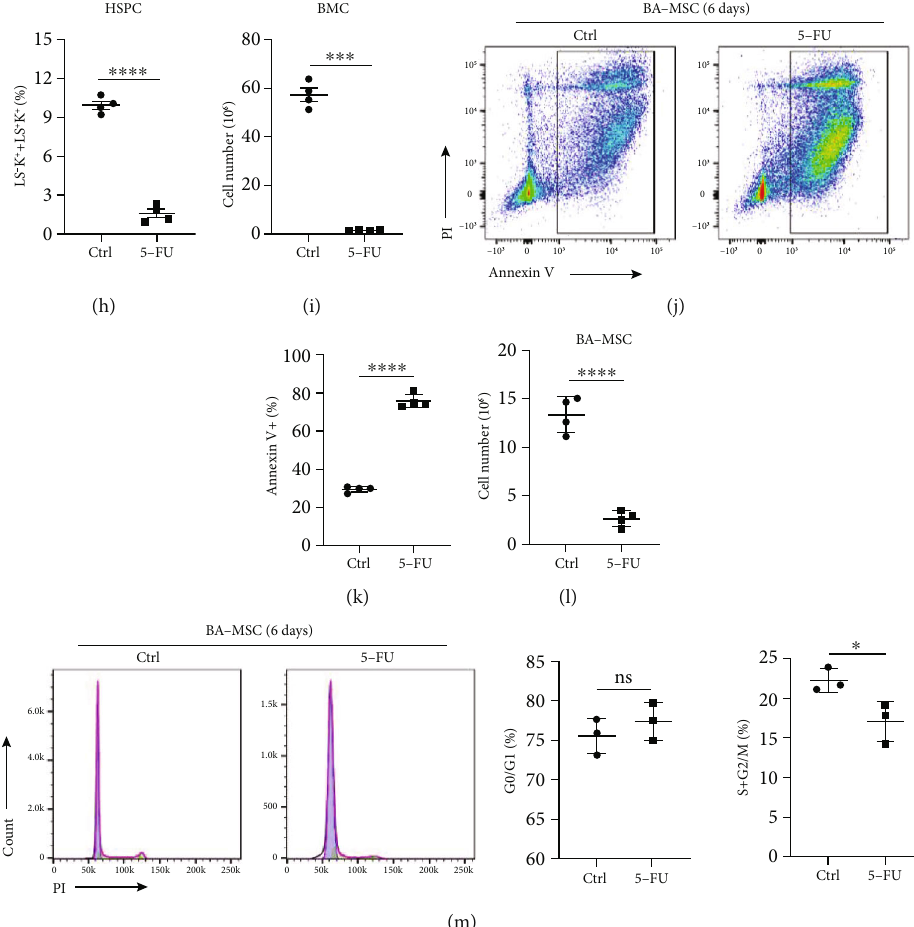
Figure 1: 5-FU induces BA-MSCs injury in vitro and in vivo . (a) Schematic of BA-MSC injury model induced by 5-FU in vitro . (b) Flow cytometric plots of apoptosis detection of BA-MSCs injured by 5-FU. (c) Flow cytometry analysis of annexin V + BA-MSC frequency in 5-FU-induced BA-MSC injury model in vitro ( n = 3 ). (d) Analysis of total cell number of BA-MSCs in 5-FU-induced BA-MSC injury model in vitro ( n = 6 ). (e) Flow cytometric plots of cell cycle and BA-MSC cell cycle statistical analysis in 5-FU-induced BA-MSC injury model in vitro ( n = 3 ). (f) Schematic of mouse myelosuppression model induced by 5-FU in vivo . (g) Flow cytometric plots of BMC subsets (HSCs and HPCs). (h) Statistical analysis of percentage of HSPCs in BMCs in myelosuppression mouse model ( n = 4 ). (i) Analysis of total cell number of BMCs in myelosuppression mouse model ( n = 4 ). (j) Flow cytometric plots of apoptosis detection of BA- MSCs in myelosuppression mouse model. (k) Flow cytometry analysis of annexin V + BA-MSC frequency in myelosuppression mouse model ( n = 4 ). (l) Analysis of total cell number of BA-MSCs in myelosuppression mouse model ( n = 4 ). (m) Flow cytometric plots of cell cycle and BA-MSC cell cycle statistical analysis in myelosuppression mouse model ( n = 3 ). (a – e) BA-MSCs in 5-FU group were treated with 12.5 μ M 5-FU for 48 h; BA-MSCs in control group were treated with 12.5 μ M DMSO for 48h. (f – m) Mice of 5-FU group were intraperitoneally injected with 5-FU (150mg/kg, 200 μ L) for 6 days; mice of control group were intraperitoneally injected with PBS (200 μ L) for 6 days. All data are presented as mean ± SEM . Statistics: unpaired Student ’ s t -test (ns: not signi fi cant; ∗ p < 0 : 05 , ∗∗ p < 0 : 01 , ∗∗∗ p < 0 : 001 , and ∗∗∗∗ p < 0 : 0001